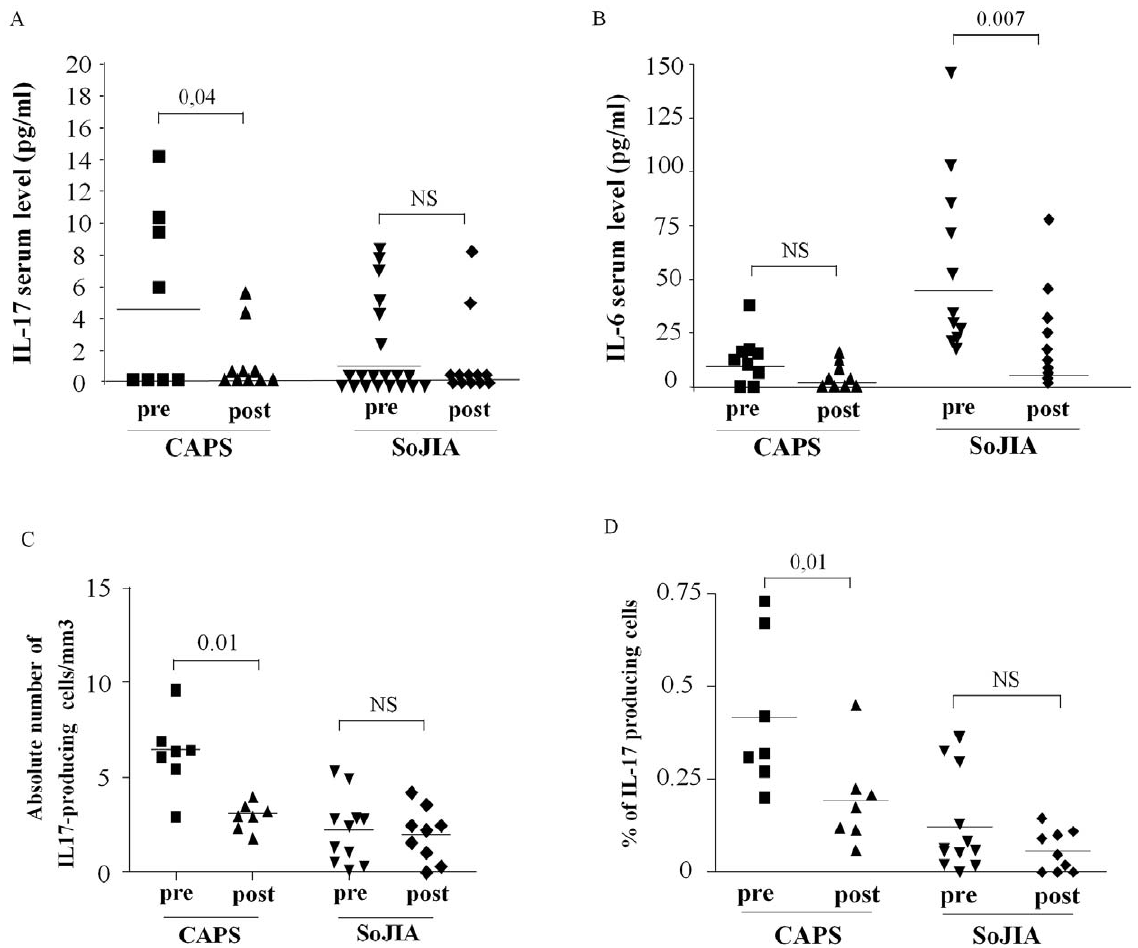
Figure 3. Effect of anti-IL-1 treatment on IL-17 and IL-6 serum levels and Th17 frequency. Variation of IL-17 (panel A) and IL-6 (panel B) serum levels after anti-IL-1 treatment in 8 CAPS patients and 11 SoJIA patients (7 responders and 5 non responders). The decrease frequency of IL-17 producing T cells after anti-IL-1 treatment is reported either as absolute number (Panel C) and percentage of alive lymphocytes (Panel D). Statistical analysis was performed using non-parametric Wilcoxon-Test.